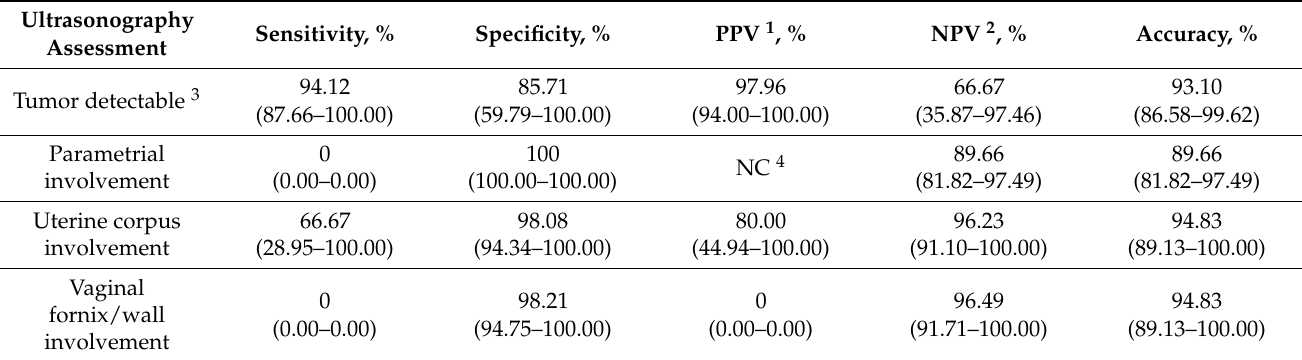
Table 4. Accuracy of ultrasonography for tumor detection and localizations of the disease ( n = 58).